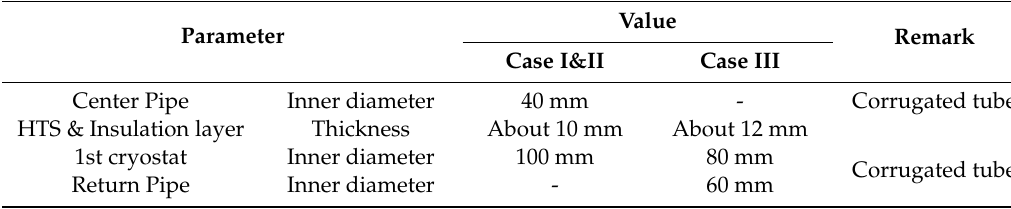
Table 3. Cable circulation pipe specification for thermal